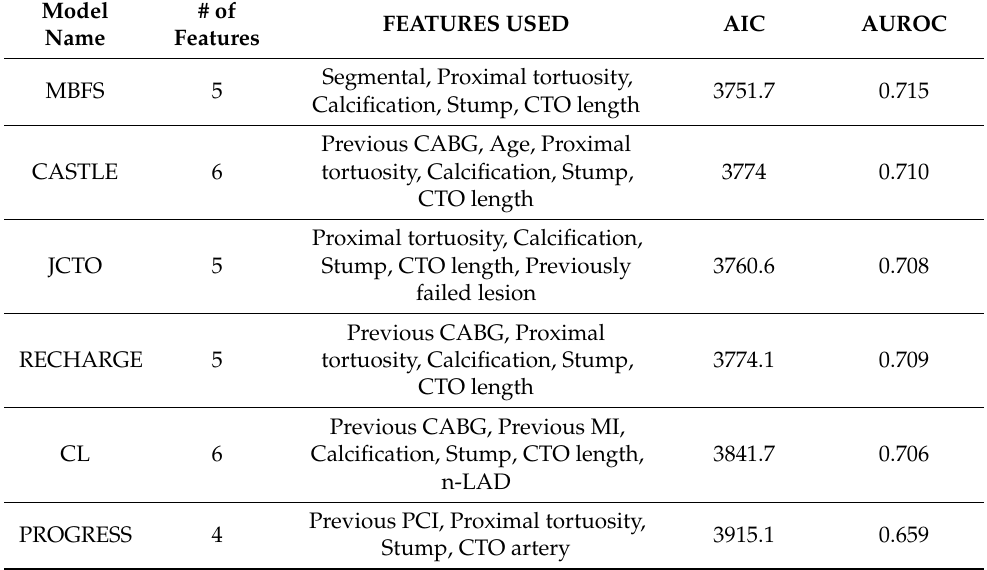
Table 3. Comparison of the six models. The number of the features is displayed for each model, along with their specific names, the Akaike information criterion (AIC) value obtained based on the corresponding logistic regression model (downsampled training dataset, n = 3026), and the area under the receiver operation characteristics (AUROC) value (test dataset, n =